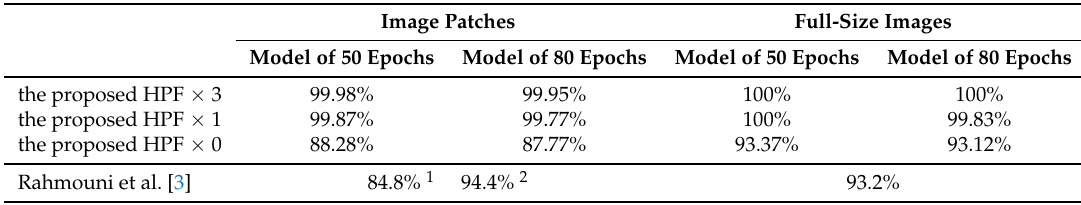
Table 1. Classification accuracy with different numbers of HPFs.